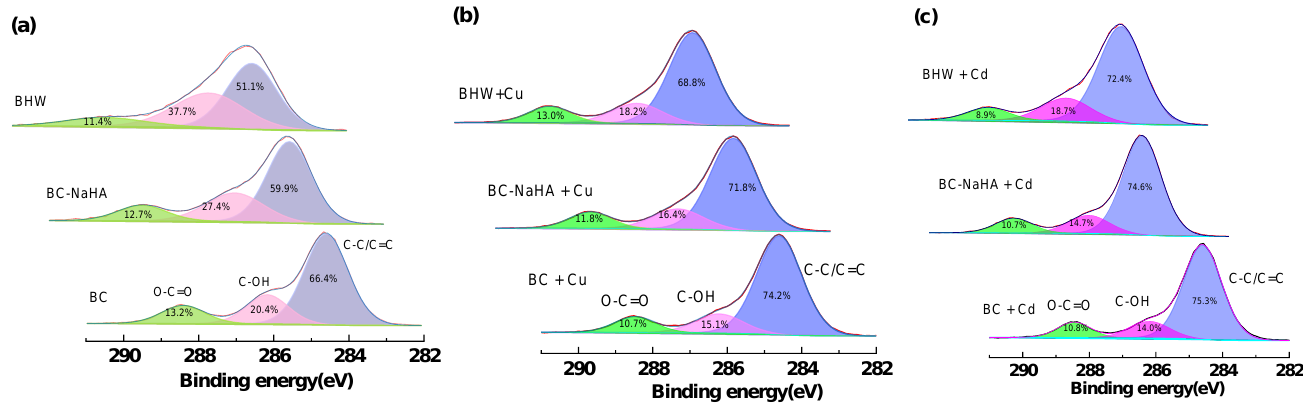
Figure 8. C1s high-resolution spectra of BC-NaHA and BHW before ( a ) and after adsorbing Cu 2+ ion ( b ) and Cd 2+ ion ( c ). After immobilizing Cu 2+ (or Cd(II)) ions in Figure 8b,c, the contents of C=C/C-C, O- C=O and C-OH in the BC spectrum are 74.2% (75.3%), 10.74% (10.8%), and 15.10% (14.0%), respectively. The contents are 71.8% (74.6%), 11.8% (10.6%), and 16.4% (14.7%) in the BC- NaHA spectrum, respectively. However, they are 68.8% (72.4%), 13.0% (8.9%), and 18.2% (18.7%), respectively. The result shows that the oxygen contents decrease by 7.8% (8.9%), 17.9% (21.5%), and 11.9% (14.7%), respectively. Compared with the oxygen contents